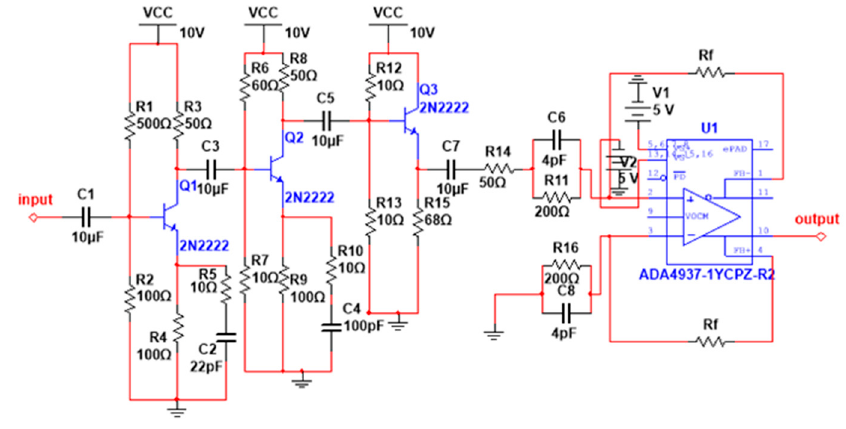
Figure 8. The pre-equalization circuit.